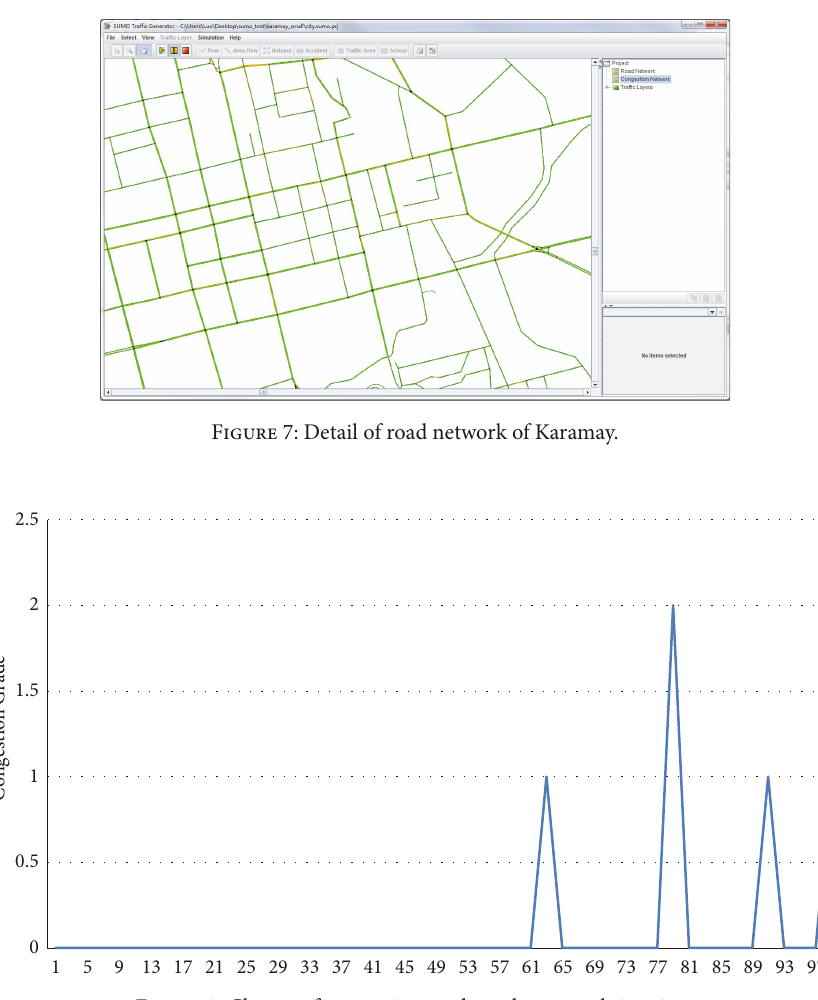
Figure 8: Change of congestion grade under normal